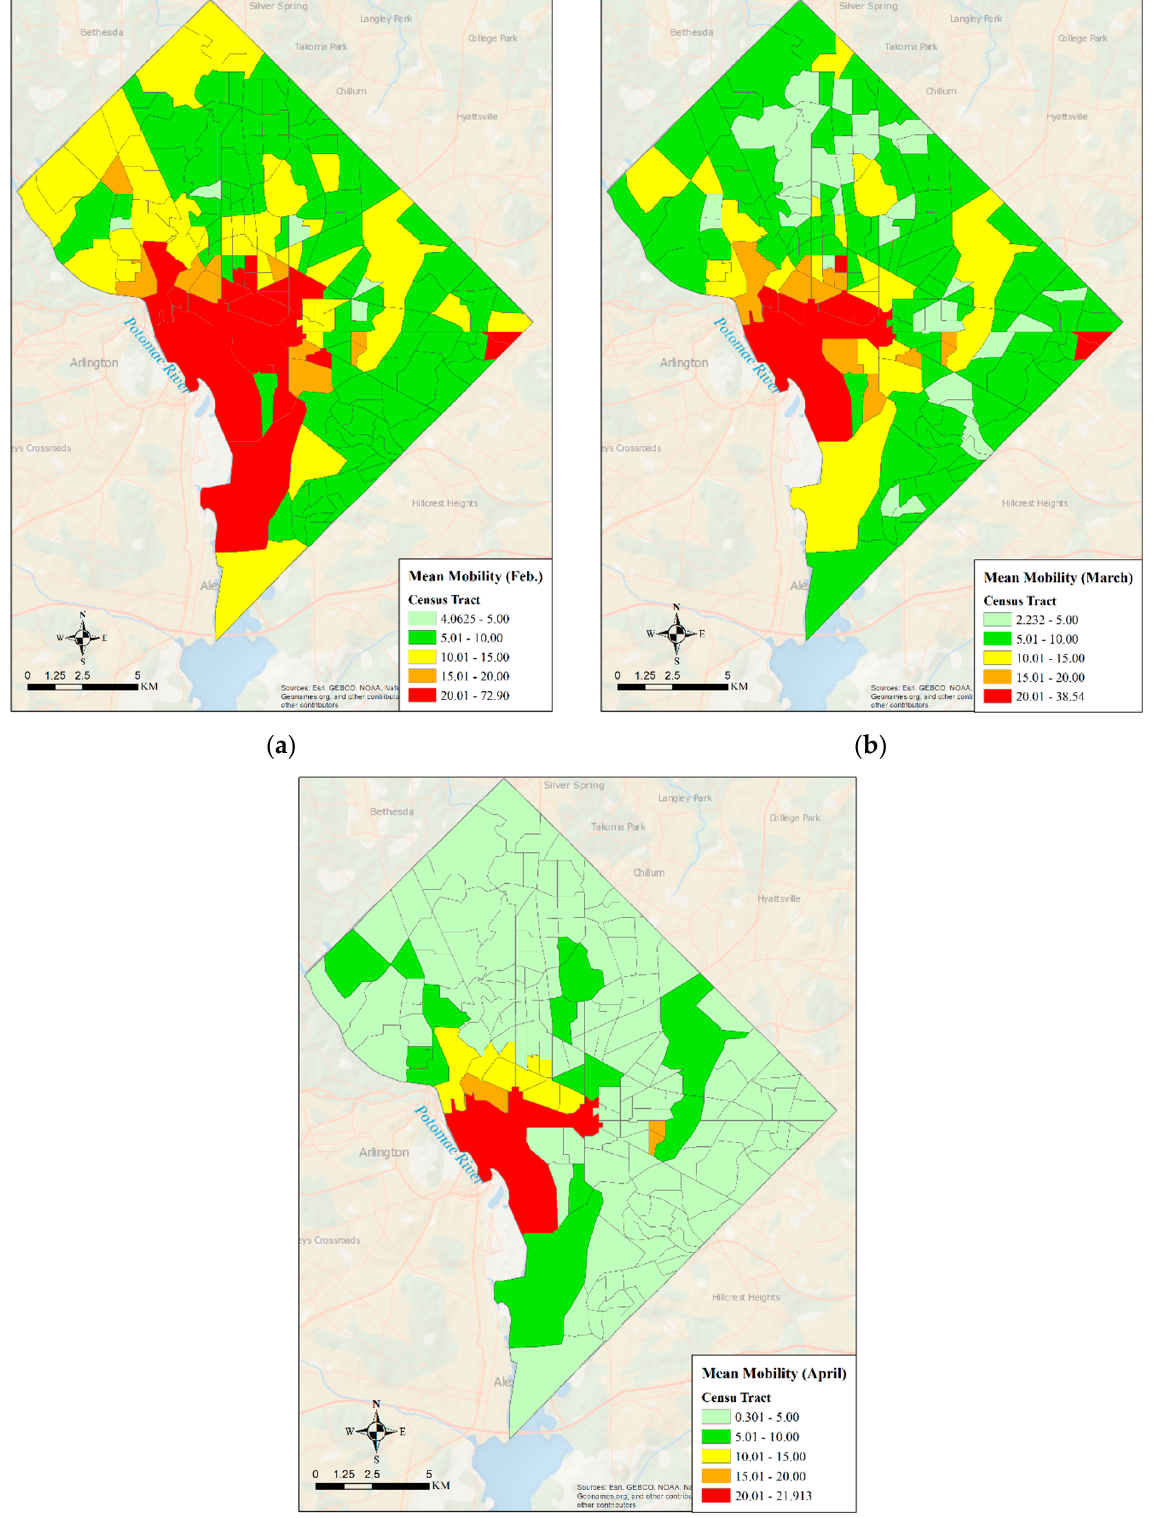
Figure 9. Mean mobility distribution in Washington, DC in February ( a ), in March ( b ), and April ( c ).